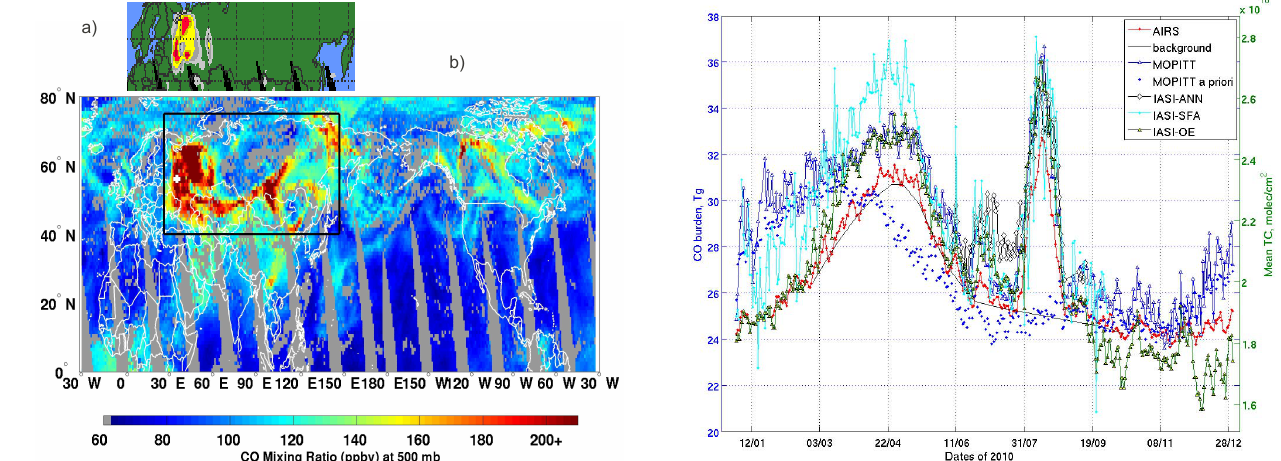
Fig. 5. (a) Map of OMI aerosol index for 9 August 2010. (b) Dis- tribution of CO VMR-500 for 9 August, 2010, according to AIRS. Black square is the area of CO averaging. Location of Moscow is marked by a white cross.